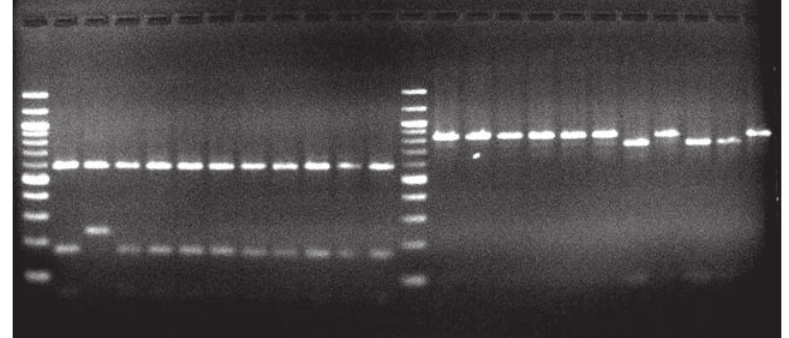
5. ITS-RFLP patterns of single spore isolates of I. jamaicensis using restriction endonucleases Alu I (Lanes 2– 12) and Hae III (Lanes 14–24). Lane 1 and 13, size marker 100 bp ladder (high-intensity: 500 and 1000 bp); lane